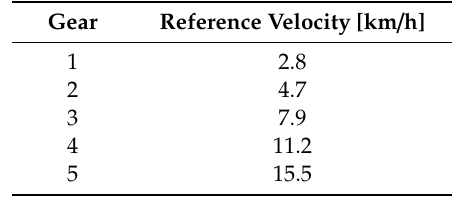
Table 7. Reference speed values.